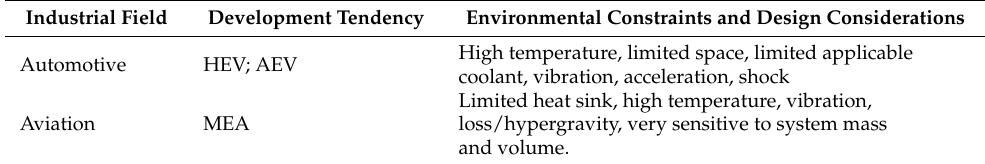
Table 2. Design features of the TMS for electronics used in automobiles and aircraft.